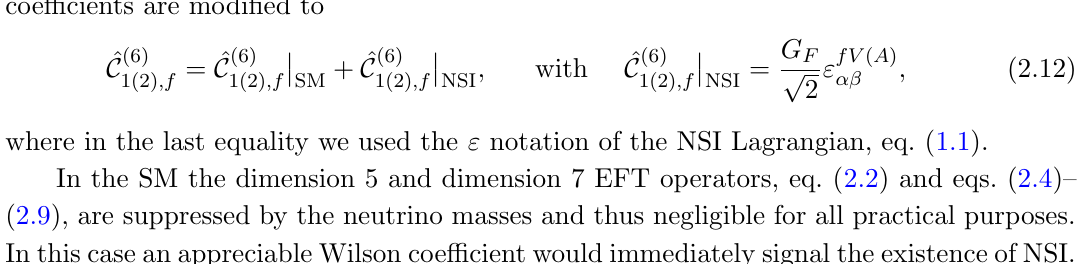
Figure 1 . Integrating out the Z and W bosons at tree level NC and CC (left) generates the e(cid:11)ective four-fermions interaction (right). The blob vertex indicates an operator insertion of (6) and 2 ;f Q